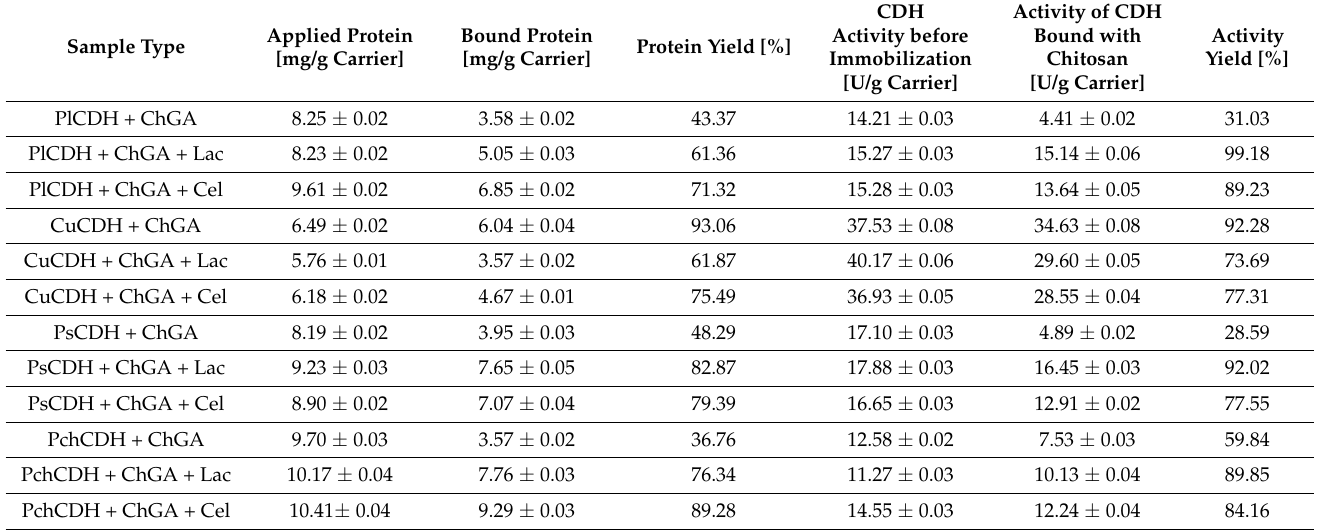
Table 2. Efficiency of cellobiose dehydrogenase immobilization with glutaraldehyde on the chitosan support (ChGA) containing CDHs isolated from P. lindtneri : Pl CDH + ChGA, with lactose Pl